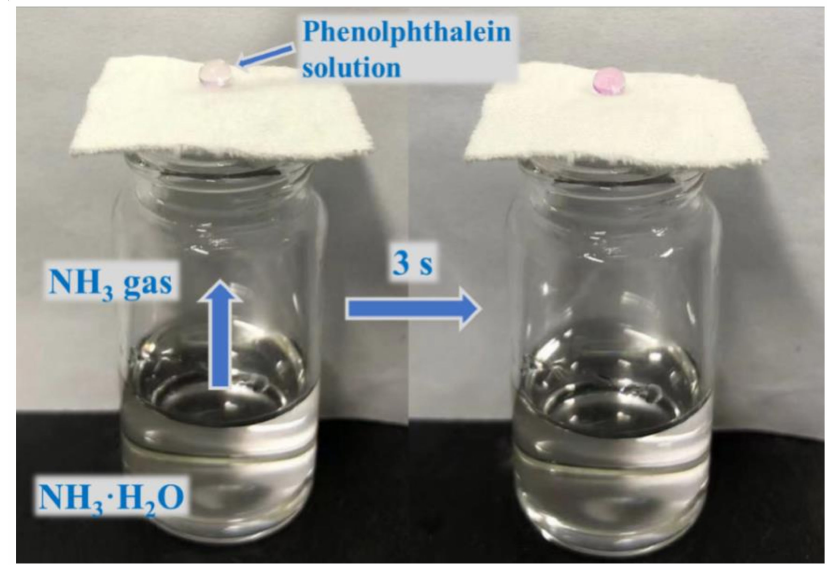
Figure 5. Image showing good air permeability of cotton